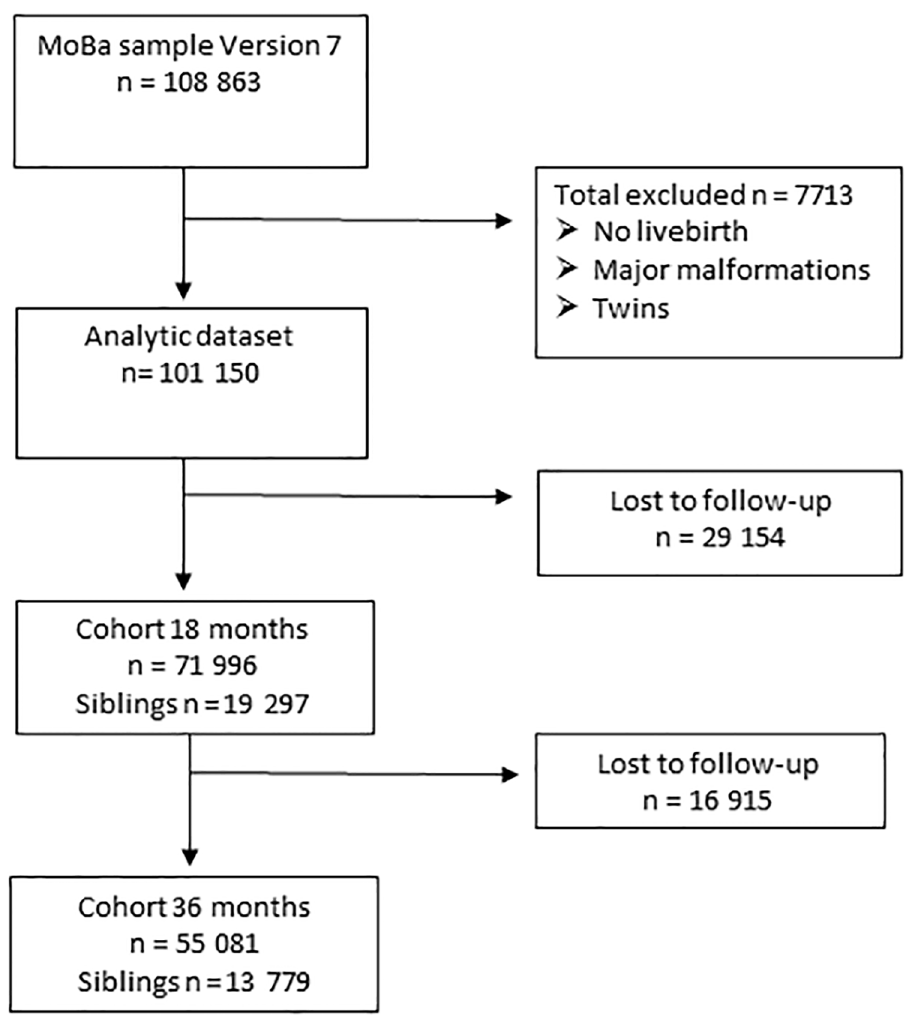
Fig 1. Flow chart of